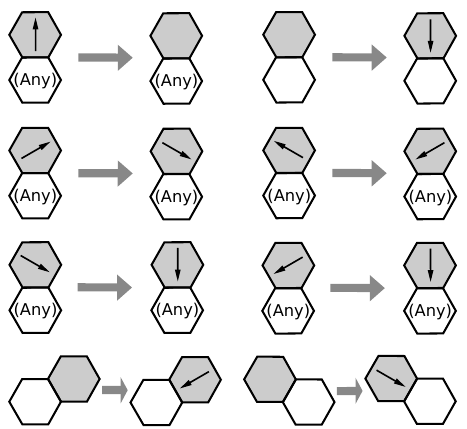
Figure 5. Illustration of gravitational rules. The bottom row shows the “falling on a slope” rule, which effectively imposes a 30 ◦ angle of repose. Modified from Tucker et al.